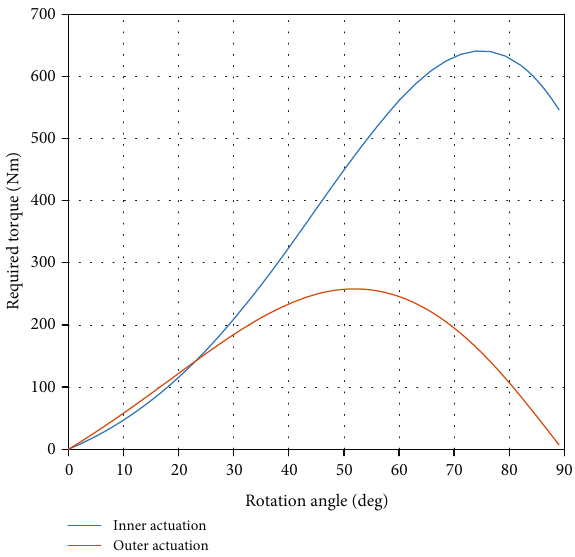
Figure 19: Required torque to achieve the requested shaft